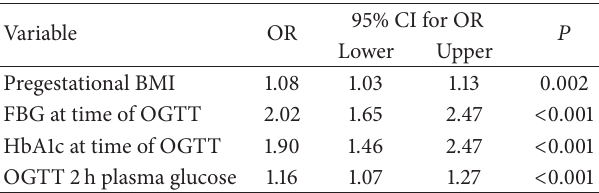
Table 2: ORs on need of AIT derived from the stepwise logistic analysis.